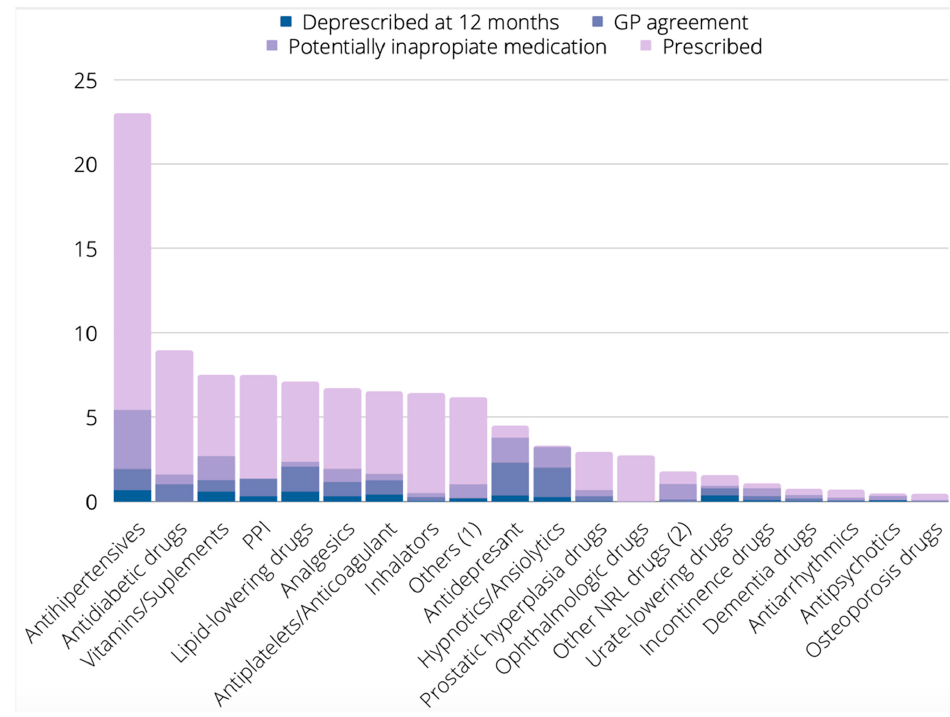
Figure 1. Percentage of prescribed medication, potentially inappropriate medication, level of agree- ment of the GP with the deprescribing proposal, and drugs eventually deprescribed at 12 months per therapeutic group. (1) Antihistamine drugs, drugs for vestibular disorders, drugs for cancer treat- ment, etc. (2) Other drugs for neurological disorders, such as epilepsy, Parkinson’s disease,